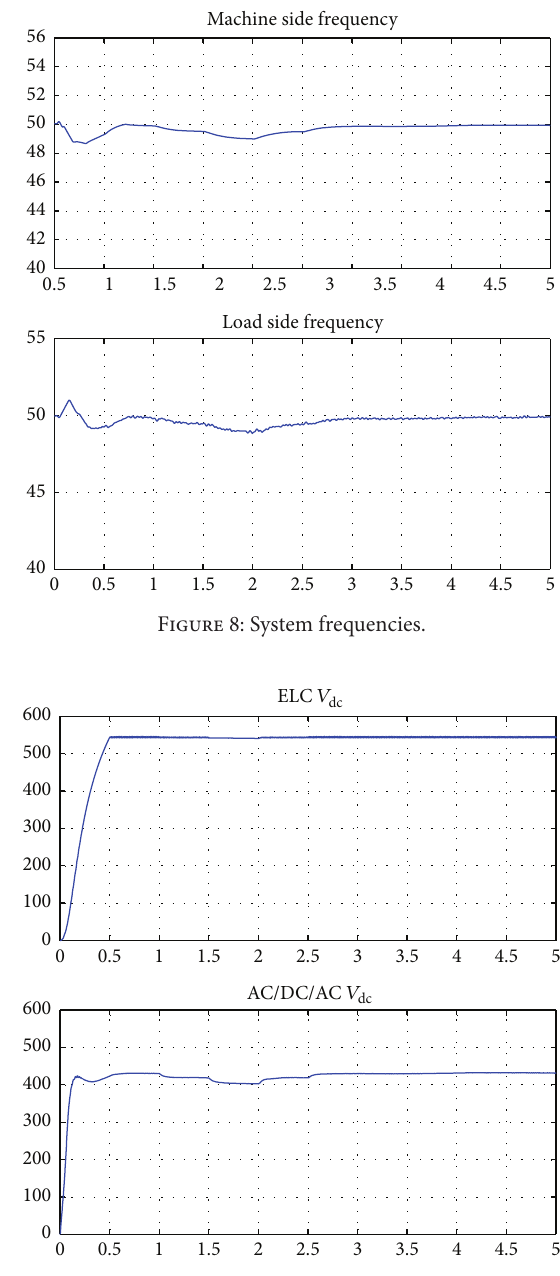
Figure 9: DC link voltage of AC-DC-AC converter and